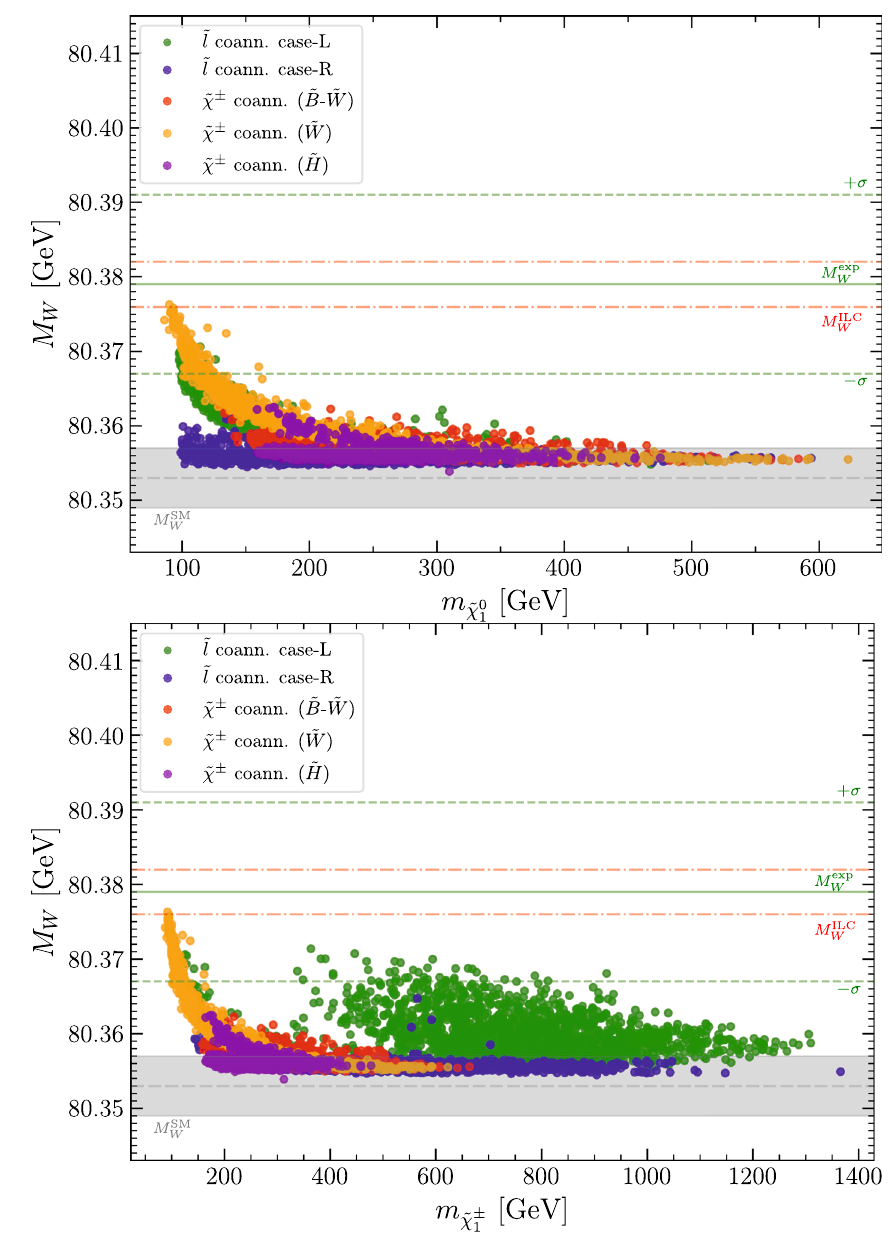
Fig. 3 Results for the five scenarios in the m ˜ χ 0 – M W plane. 1 The horizontal lines and the color coding are as in Fig. 1